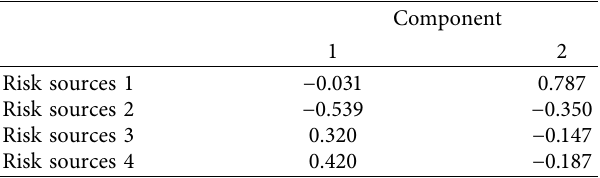
Table 13: Scale of